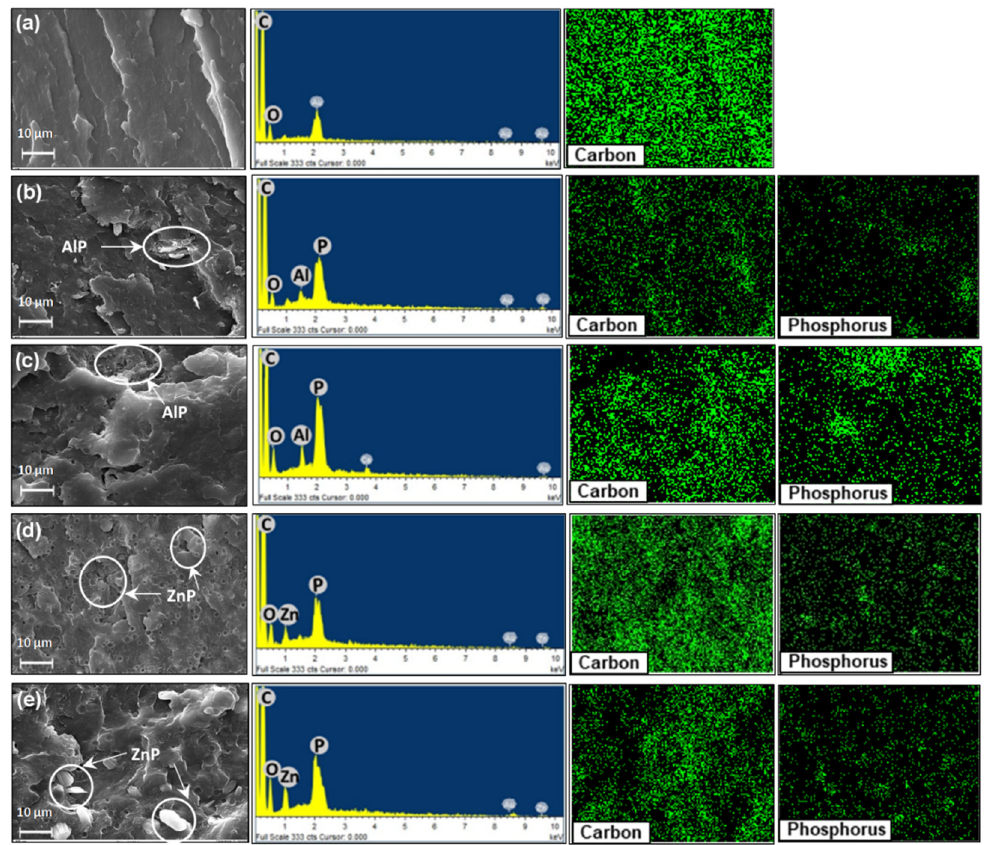
Figure 2. Scanning Electron Microscopy (SEM) micrographs of unfilled polyamide 11 (PA11) and the ternary blends. ( a ) PA11; ( b ) PA 80 -LL 10 -AlP 10 ; ( c ) PA 80 -DL 10 -AlP 10 ; ( d ) PA 80 -DL 10 -ZnP 10 and ( e ) PA 80 -LL 10 -ZnP 10 at 2500 × magnification and corresponding energy dispersive X-rays (EDX) spectra and elemental maps.